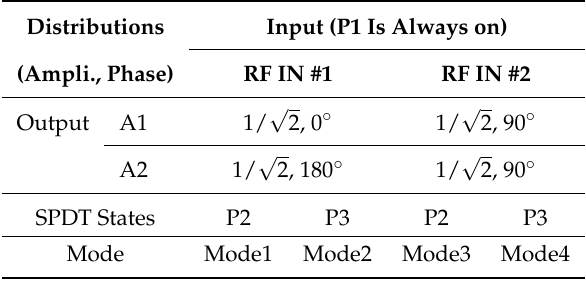
Table 1. Amplitude and phase distributions with SPDT states.